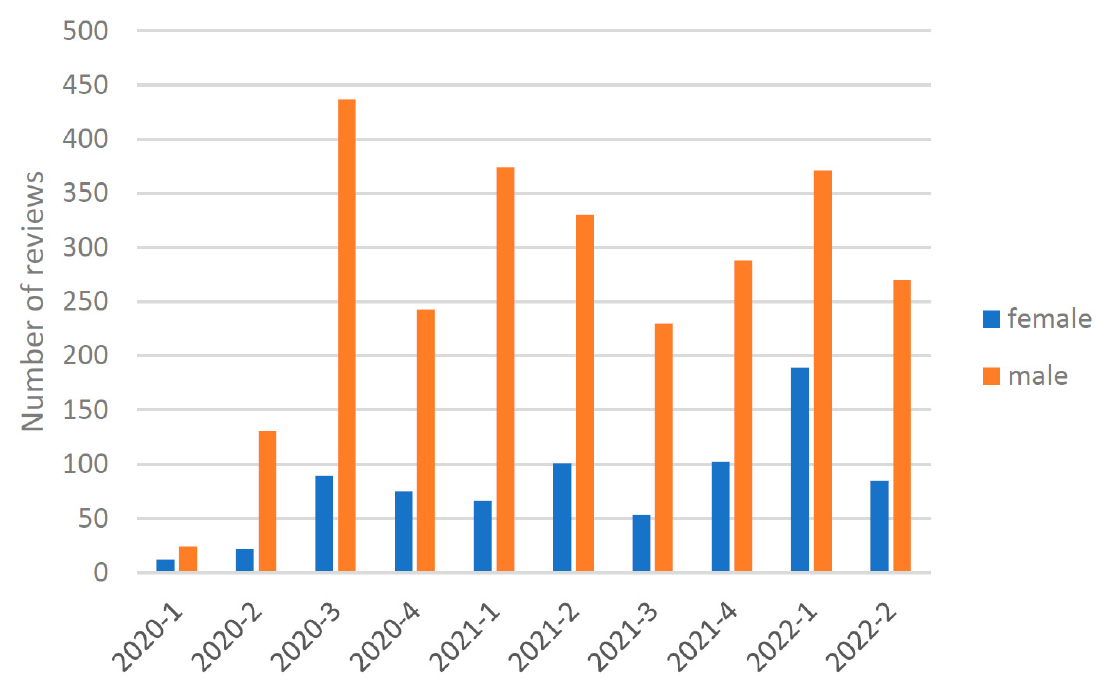
Figure 5. Number of reviews by female and male by quarters from 2020 to 2022.